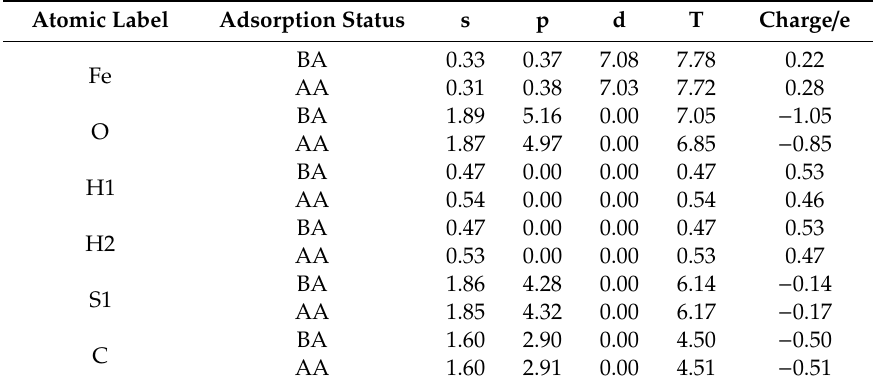
Table 5. MCP of atoms at the doping-position.